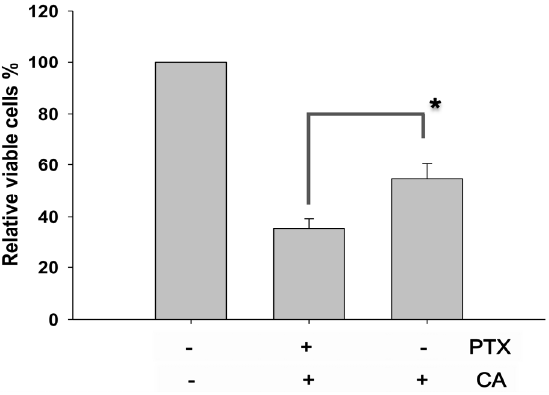
Figure 2. Protective effect of CA on paclitaxel (PTX)-treated A549 cells. Cells were co-treated with 100 μ M of CA and the indicated drugs for 48 h respectively. Afterwards, the proliferation rate was determined using the assay of trypan blue exclusion. * p < 0.05 against PTX-treated alone.